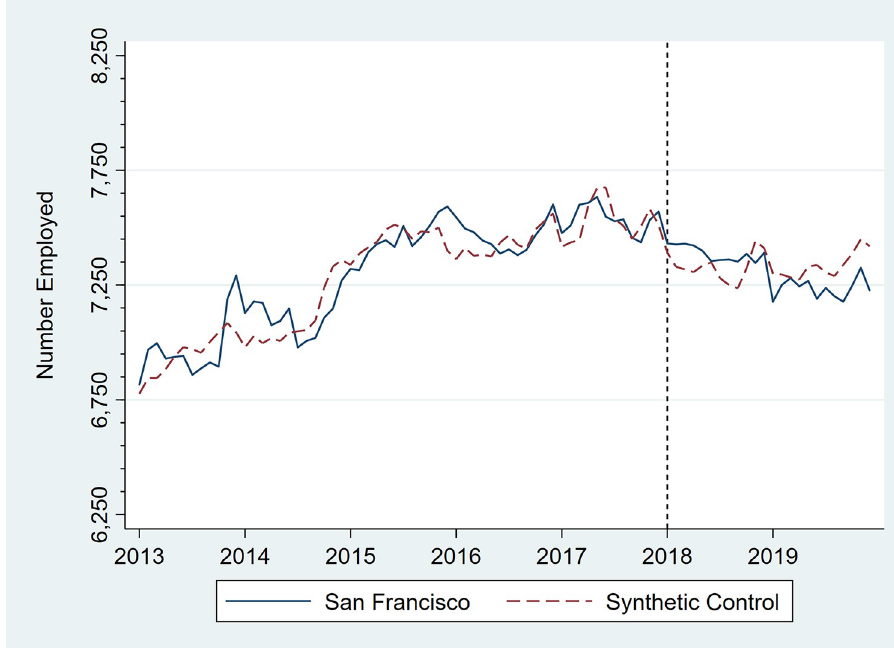
Fig 3. Number of persons employed in supermarkets and other grocery stores, San Francisco, CA, and its synthetic control, monthly, January 2013 through December 2019.